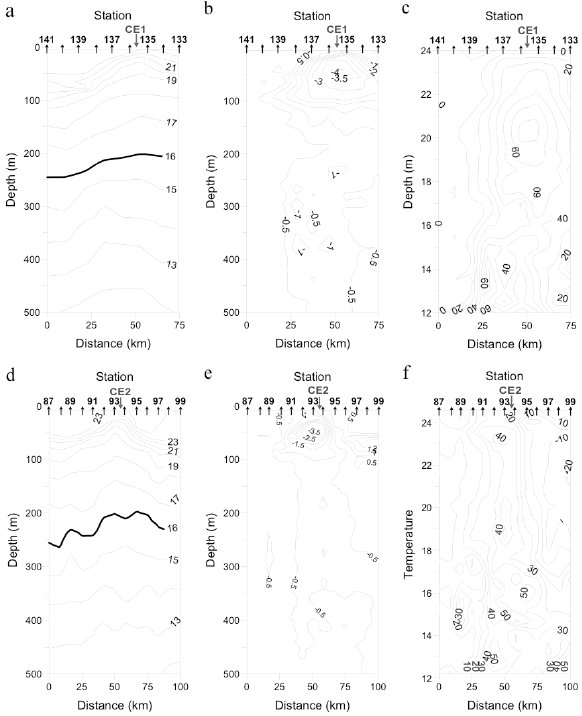
Fig. 2. Vertical sections from XBT transects showing the signals of cyclonic eddies CE1 and CE2. Left panels: temperature ( ◦ C) section for (a) CE1 and (c) for CE2. Right panels: temperature anomaly ( ◦ C) sections for (b) CE1 and (d) CE2. Grey arrow in the top axes indicates the location of the eddy center signal. internal Graphik ist zu klein zu lesen, bitte groesser